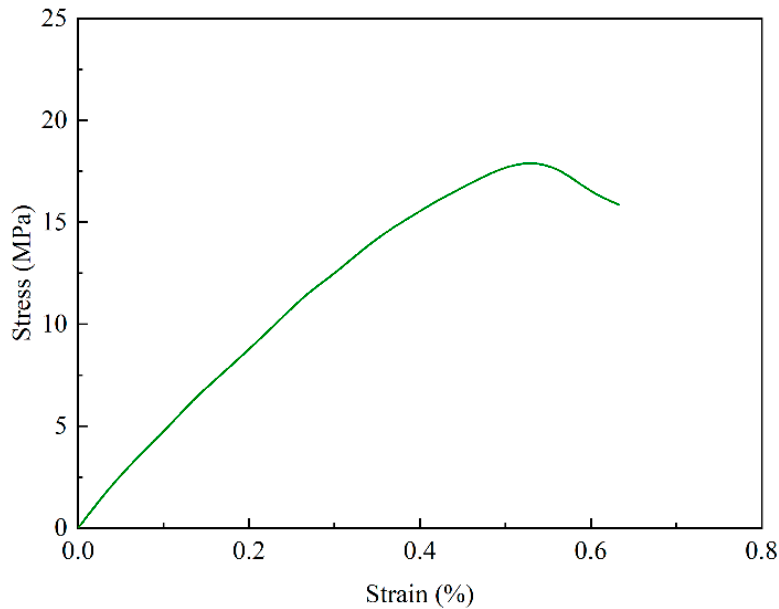
Figure 9. Stress–strain